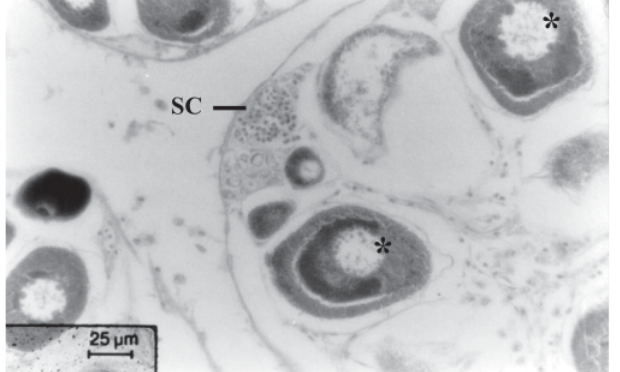
Fig. 9. Development of spermatid crypts (SC) in the estroma of Mycteroperca bonaci in transition period. Presence of countless oocytes with their nucleus erode and the fragmented cytoplasm (*). Stain: H.